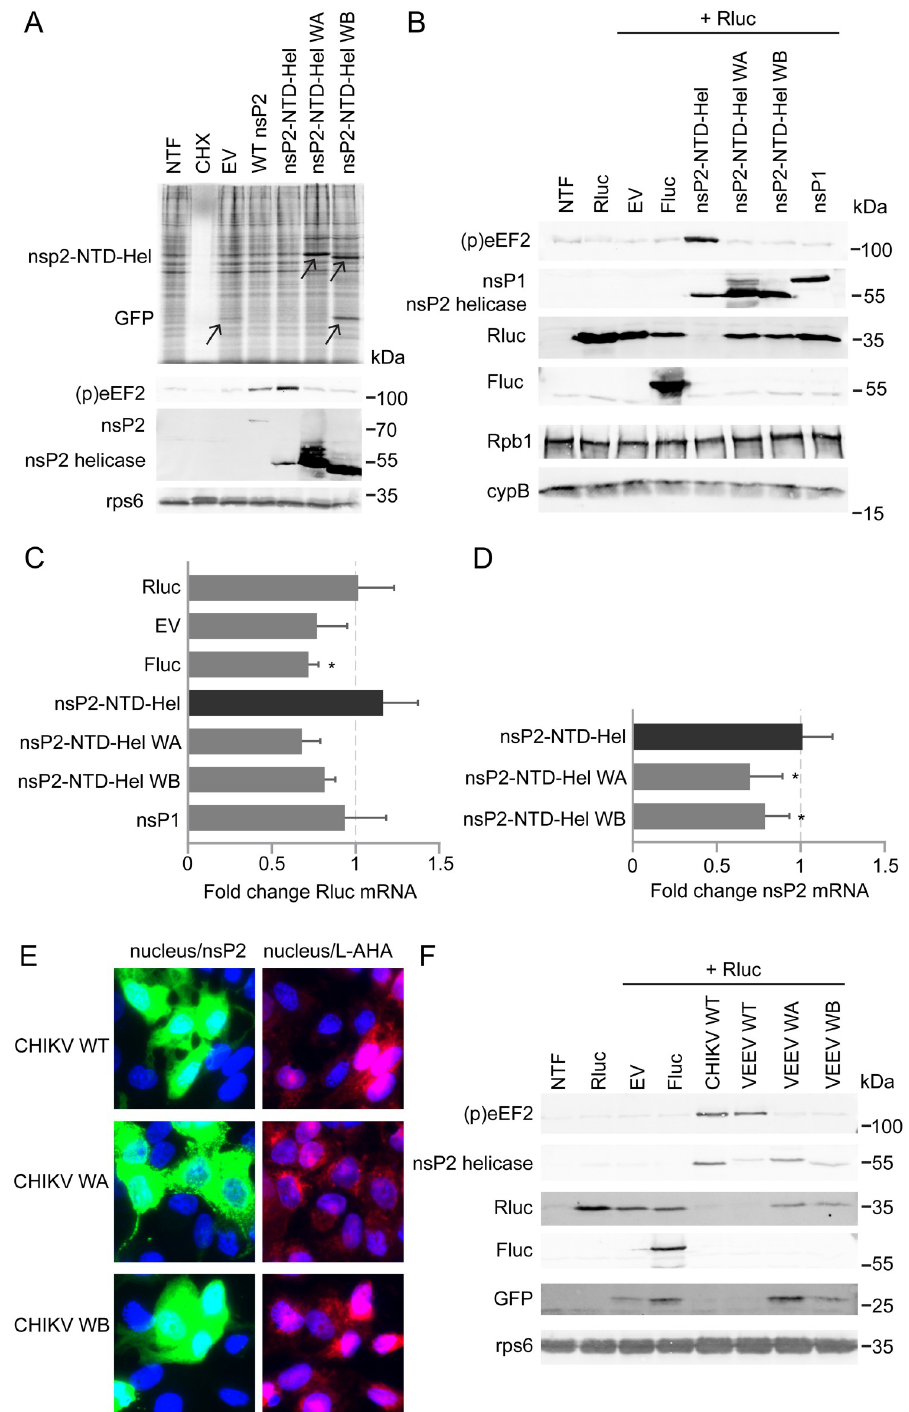
Fig 9. The helicase-associated NTPase domain of nsP2 inhibits translation. ( A ) Top: 293T cells transfected with the pCAGGS-IRES-GFP construct containing the nsP2-NTD-Hel WT sequence or the Walker A and Walker B motif mutants and metabolically labeled with 35 S-methionine and 35 S-cysteine for 30 min. Cells treated with 50 μ g/ml cyclohemixide (CHX) and cells transfected with an empty vector and non-transfected cells (NTF) were included as controls. Cell lysates were separated by SDS-PAGE and a Storage Phosphor screen was exposed to the dried gel. Bottom: Non-radioactively labeled cell lysates were harvested in parallel and (p)eEF2 (T56) and CHIKV nsP2 helicase